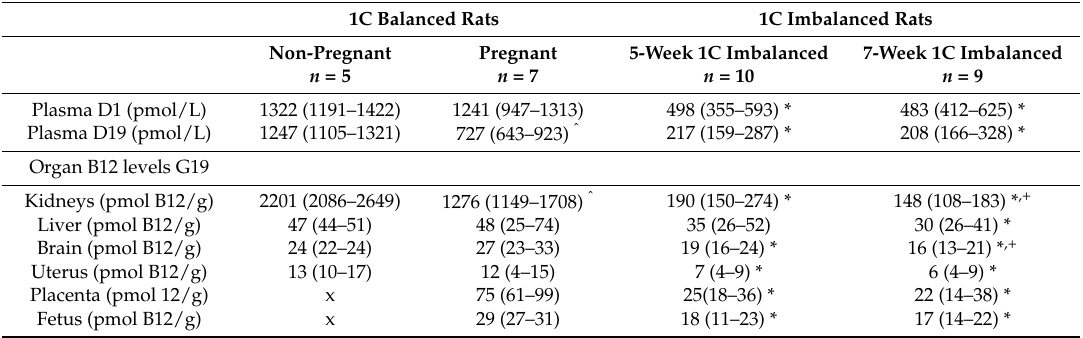
Table 3. Endogenous B12 in maternal tissues and fetuses. B12 content in plasma and organs from 1C balanced and 1C imbalanced rats before pregnancy (only plasma) and at gestation day 19. 1C Balanced Rats